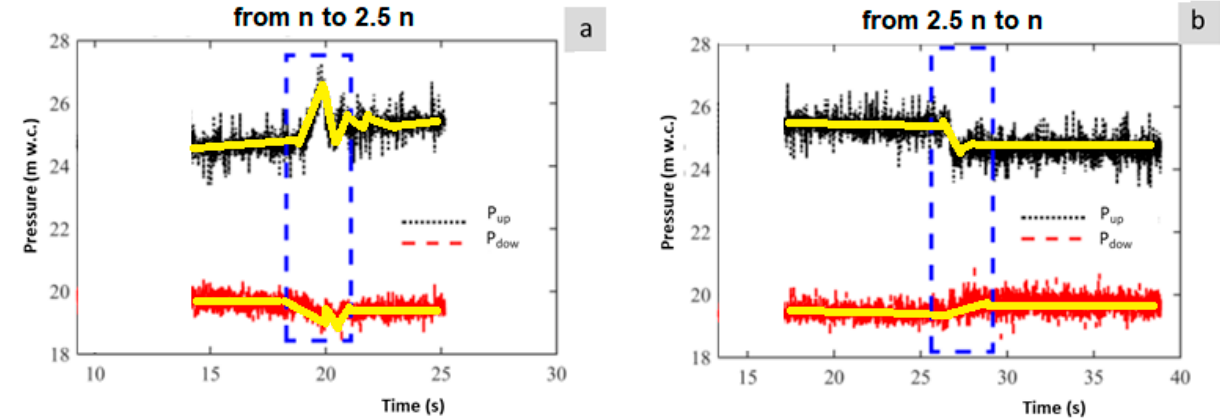
Figure 10. Experimental transient regimes: ( a ) upstream and downstream pressure variation for an increase in the rotational speed; ( b ) and a decrease in the rotational speed.